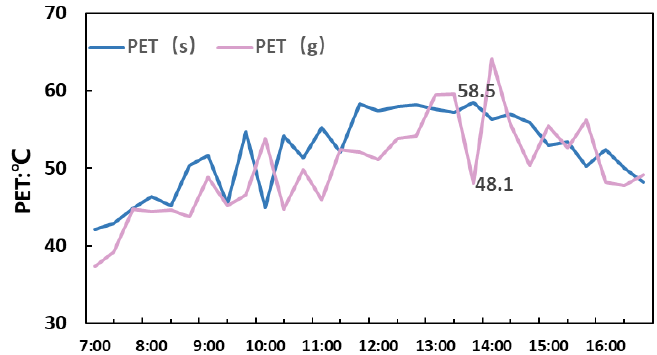
Figure 11. PET calculation results of representative day in summer.